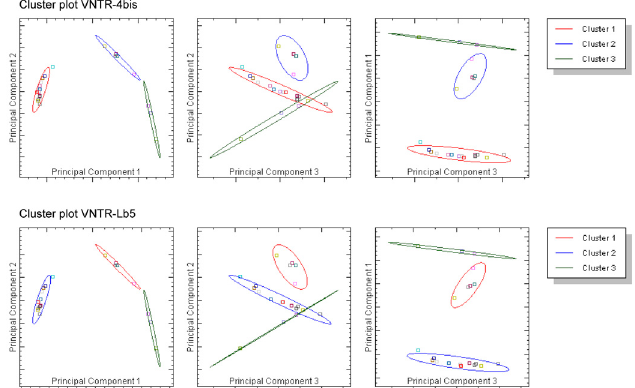
Fig 5. Cluster plot obtained after the HRM analysis using the VNTR-4bis and